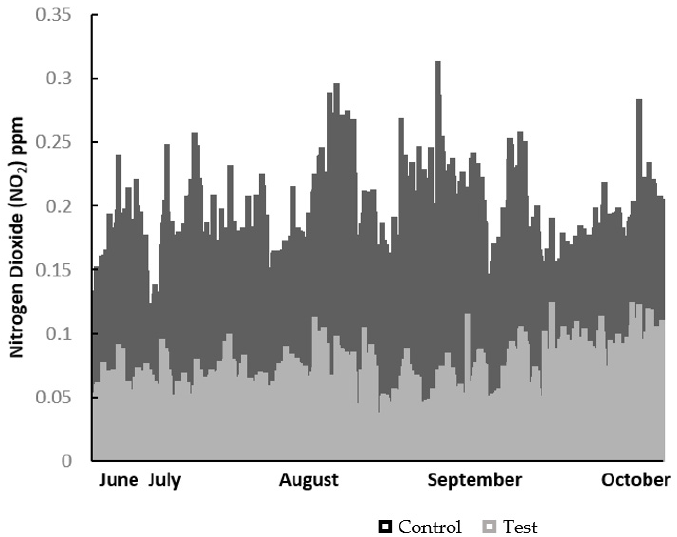
Figure 6. Difference (ppm) between test and control sites for nitrogen dioxide (NO 2 ), June to October 2017.